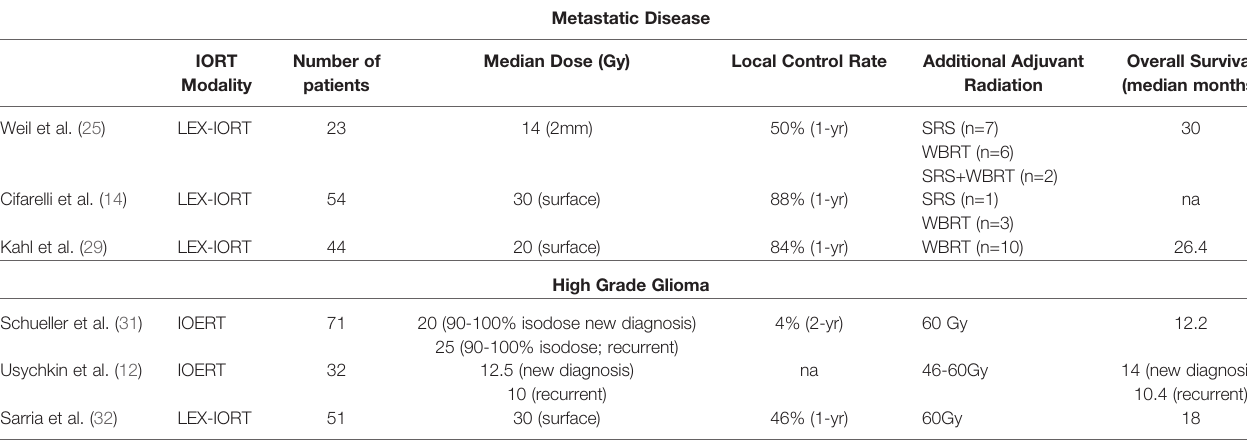
TABLE 1 | Clinical outcome studies of IORT in brain metastases and